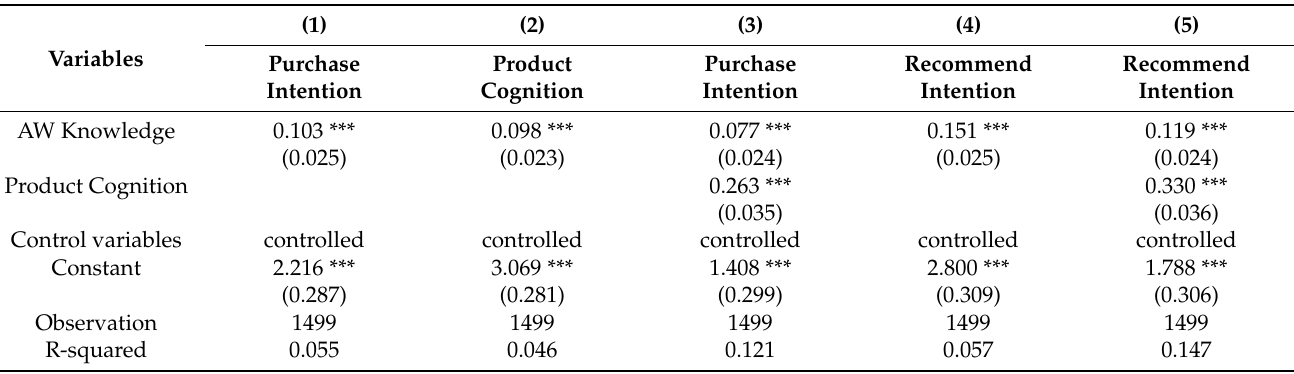
Table 7. Mediating effects of product